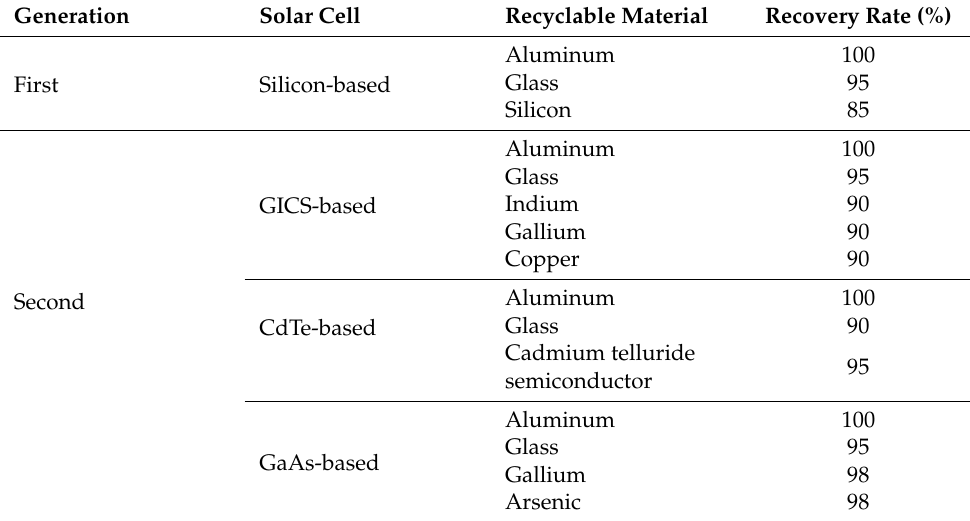
Table 6. Solar waste recycling information